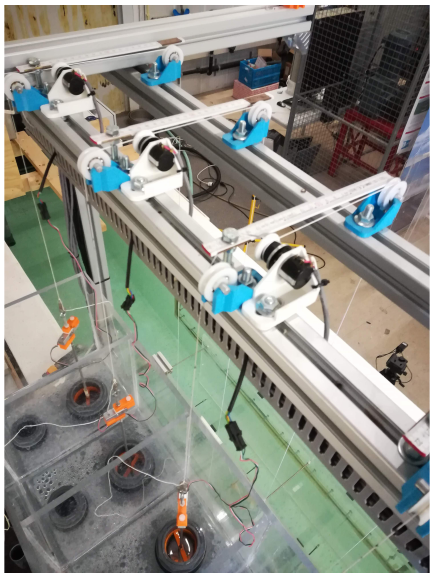
Figure 9. Top view of the pumping system. The high-performance polyethylene cables transfer the motion from the flexible floater to the pistons inside the